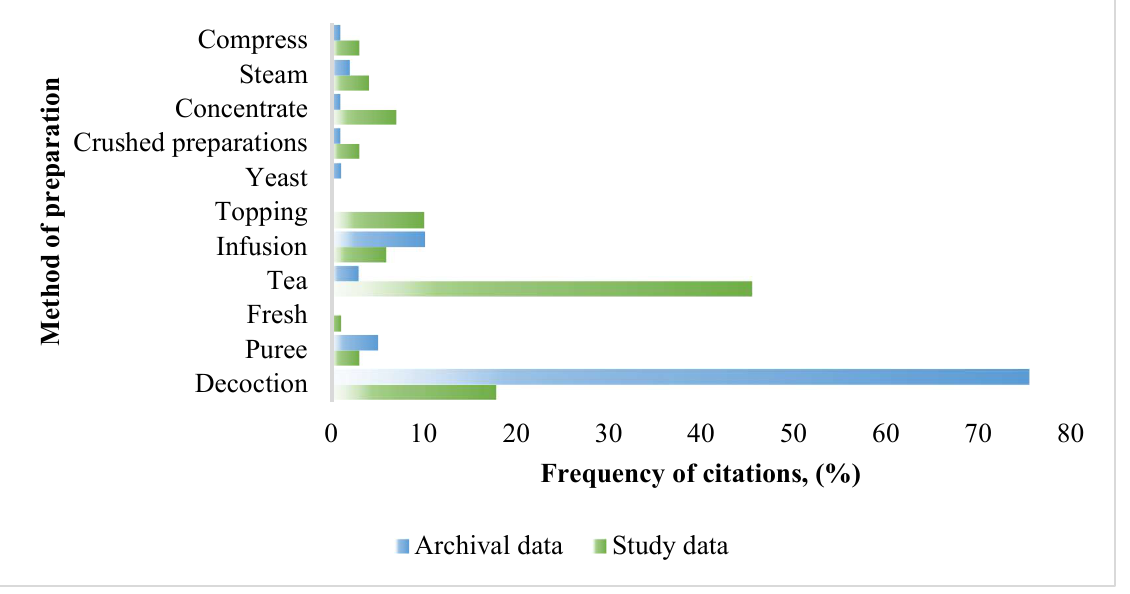
Figure 5. The methods of preparing the herbal medicines .